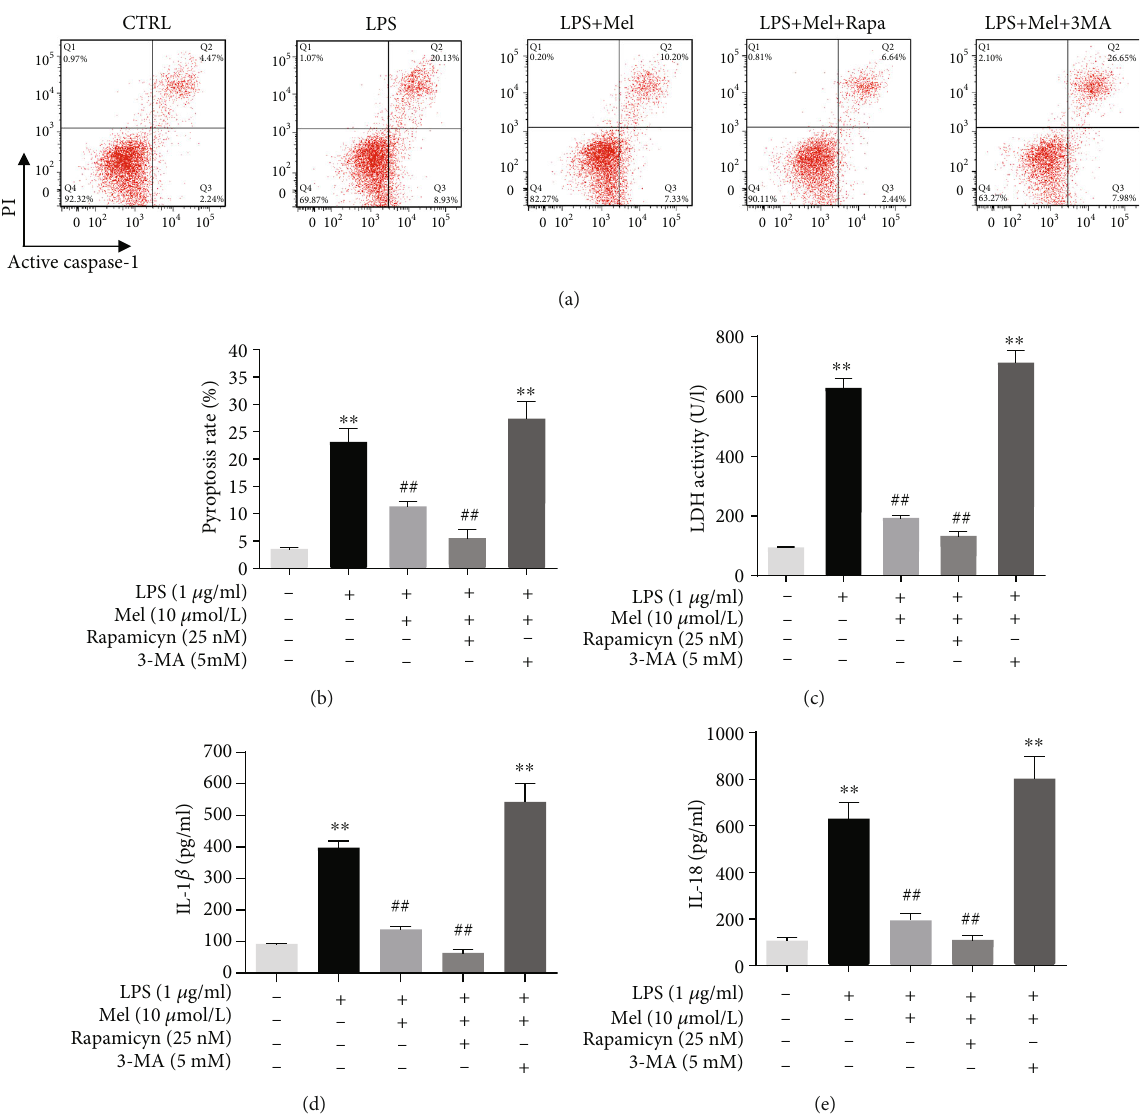
Figure 6: Melatonin attenuates pyroptosis in LPS-exposed hiPSC-CMs via enhancing autophagy. (a) Representative images of fl ow cytometry results. (b) Quantitative analysis of pyroptosis rate. (c) Measurement of LDH release level. (d) Supernatant IL-1 β level examined by the ELISA assay. (e) Supernatant IL-18 level examined by the ELISA assay. Mel was administered at 10 μ mol/l. n ≥ 3 ; ∗ P < 0 : 05 vs. control; ∗∗ P < 0 : 01 vs. control; # P < 0 : 05 vs. LPS; ## P < 0 : 01 vs.